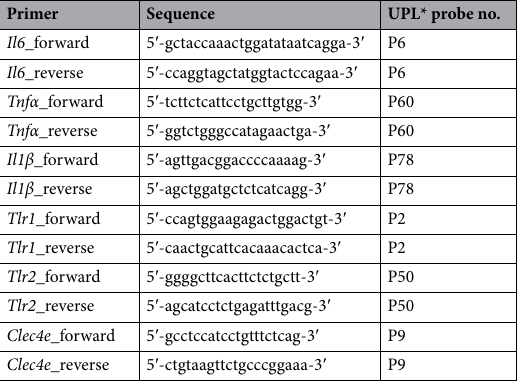
Table 2. List of primers used in qRTPCR. UPL universal probe